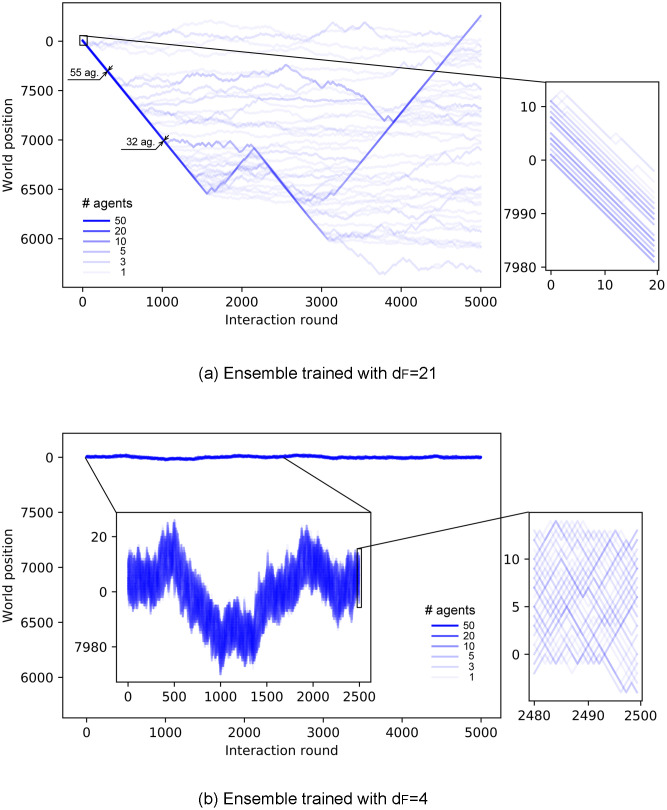
Trajectories of an ensemble of 60 agents, in a world of size W = 8000, shown over 5000 interaction rounds.(a) Agents trained with dF = 21 form a swarm that continuously loses members until it dissolves completely. (b) Agents trained with dF = 4 form a highly cohesive swarm for the entire trial. The centered inset of this plot shows the first 2500 rounds, with a re-scaled vertical axis to observe the movement of the swarm. Insets on the right zoom in to 20 interaction rounds so as to resolve individual trajectories.